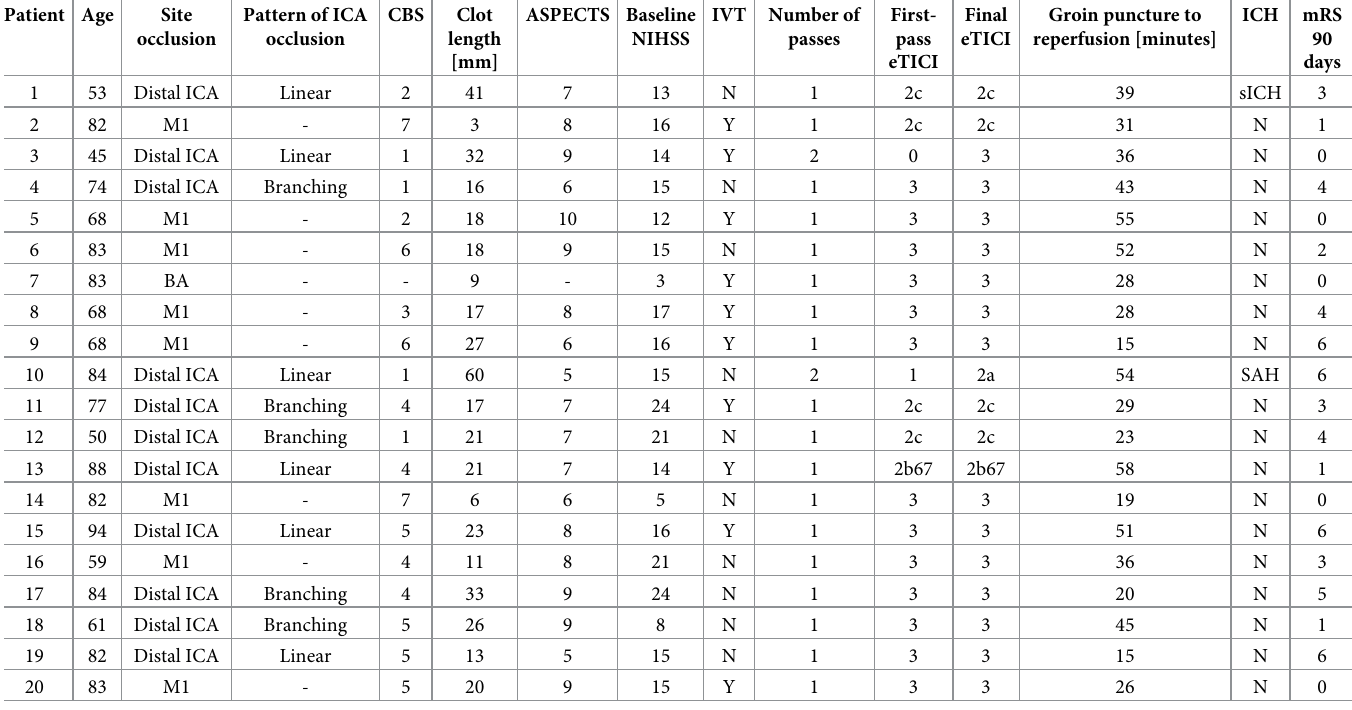
Table 2. Overview about imaging, procedural, and clinical